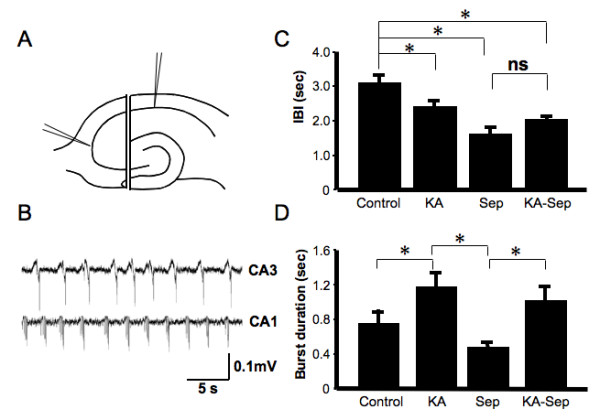
Effects on synchronized neuronal events of acute surgical separation of CA3 from CA1 illustrates the importance of CA3 pacing on CA1 firing. (A) Schematic diagram showing the surgical separation of CA3 from the remaining slice. (B) Synchronized neuronal firing under Mg2+-free conditions in slices is disrupted following CA3 separation. Events in CA1 and CA3 are no longer in phase or of similar frequency. (C) IBI of synchronized events in CA1 following separation from CA3 in both control and KA-treated slices (mean ± SEM, * p < 0.05, n = 6, one-way ANOVA). (D) Duration of bursts in CA1 following CA3 removal in both control and KA-treated slices (mean ± SEM, * p < 0.05, n = 6, one-way ANOVA).